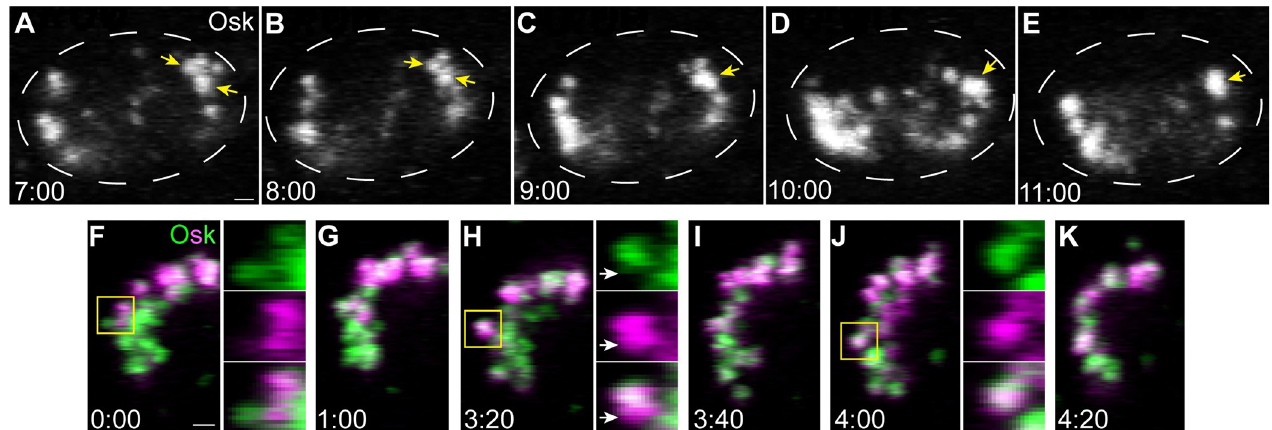
Fig 2. Germ granules grow by fusion in the pole cells. Maximum intensity confocal z-projections of a 1 μ m region of a representative pole cell at nc14 with endogenously tagged Osk-sfGFP (A–E) or Osk-Dendra2 (F–K). Osk-sfGFP and Osk-Dendra2 images were taken from a 5-min period of S1 Video and a 4-min period of S2 Video, respectively. Yellow arrows and boxes indicate germ granules that undergo fusion. Enlargements of the boxed regions in (F), (H), and (J), show the mixing of green and red (shown here in magenta) fluorescent Osk-Dendra2 signal over time. White arrows indicate a region of a granule where the magenta labeled and green labeled contents have yet not mixed after fusion. Time stamps indicate minutes:seconds. Scale bar: 1 μ m.